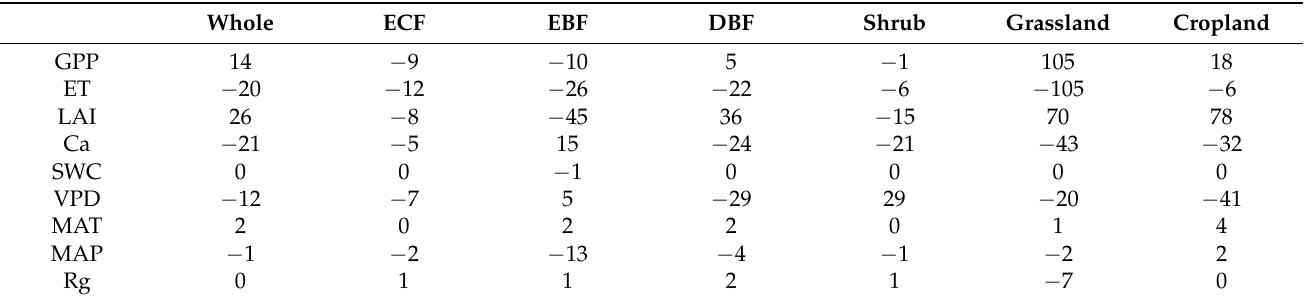
Table 2. Actual contributions of GPP, ET, climate change, LAI, and Ca to annual WUE trends for different landscapes in subtropical China ( × 10 − 4 g C/m 2